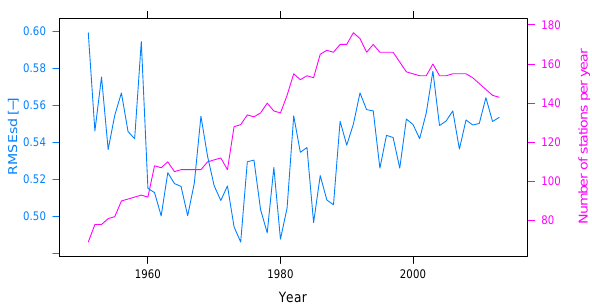
Figure 10. Annual RMSEsd median (blue) and number of avail- able stations per year (pink) for minimum temperature in the period 1951–2013. The daily results, also summarized in Table 1, were used for calculating the annual